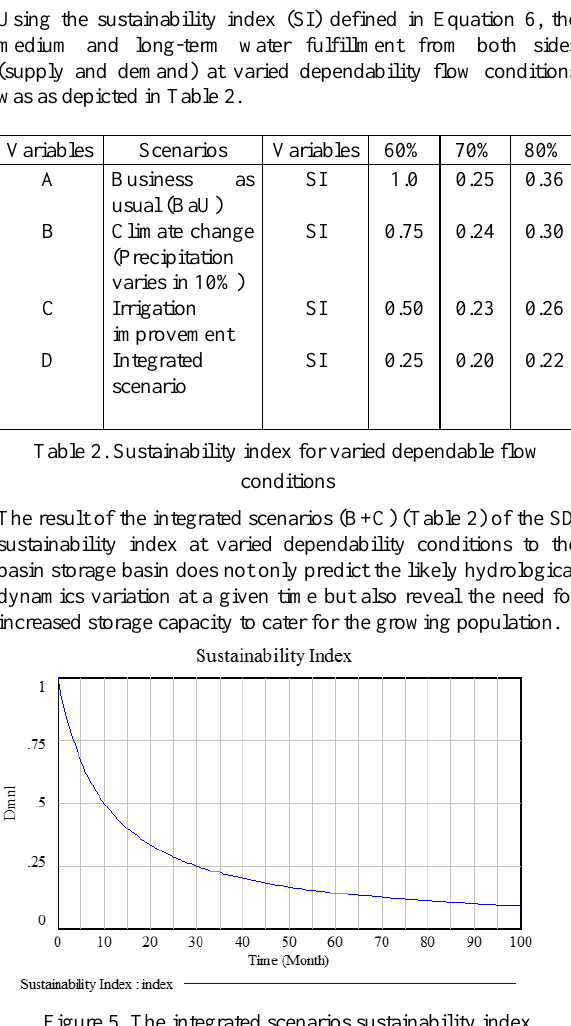
Figure 5. The integrated scenarios sustainability